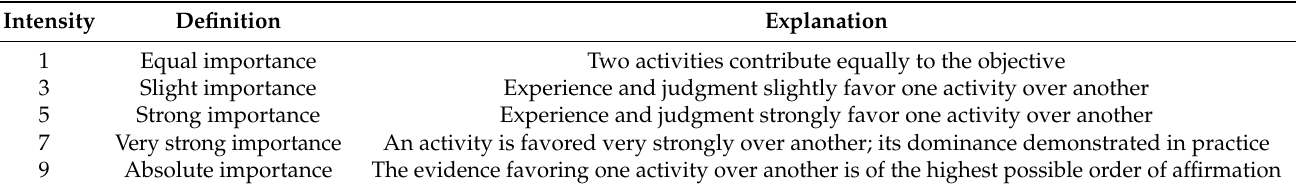
Table 4. Fundamental absolute number scale—adapted from